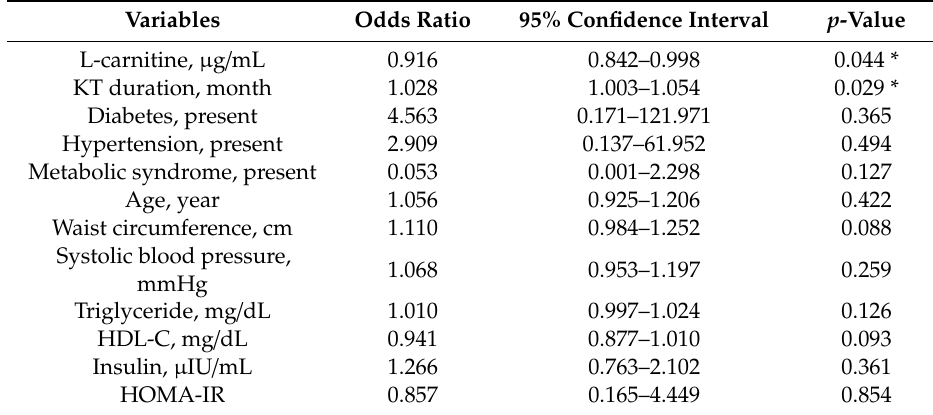
Table 3. Multivariate logistic regression analysis of the factors correlated to peripheral arterial disease among the 65 renal transplant